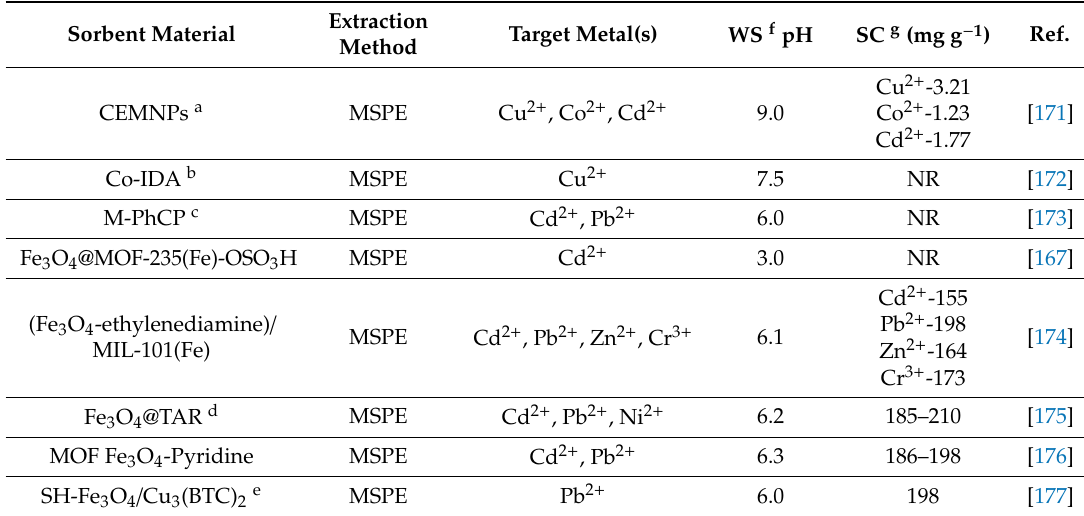
Table 7. Magnetic-based sorbent materials for metal ion